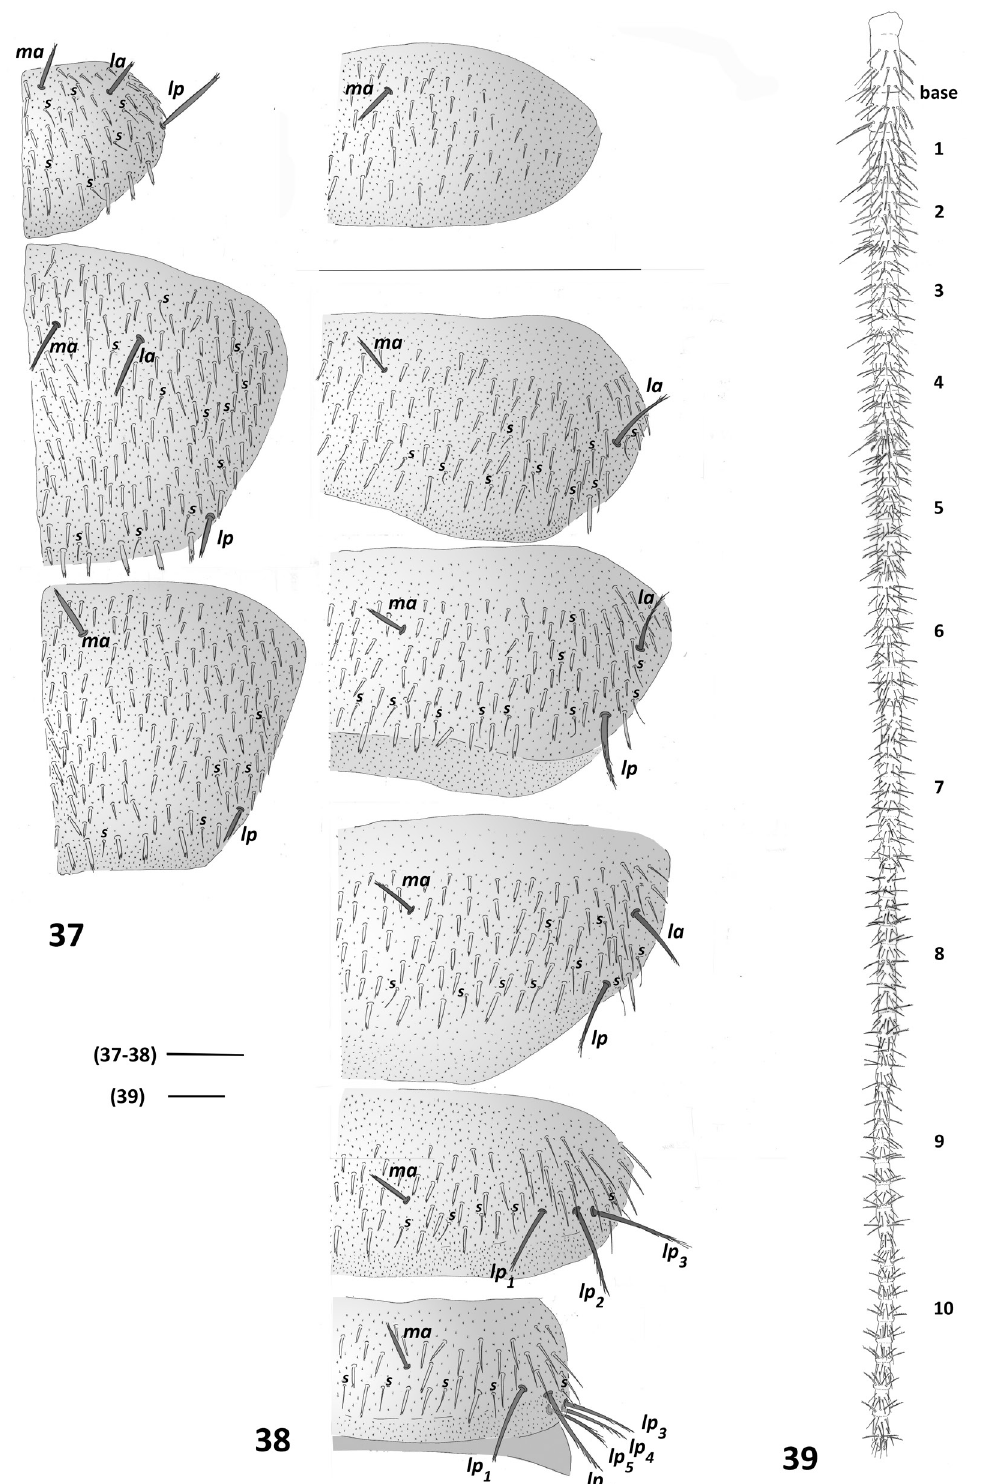
Figs 37–39. Campodea ( Campodea ) lubbockii Silvestri, 1912. 37 . ♀, 4 mm, from Geneva, Switzerland, pronotum, mesonotum and metanotum, right side. 38 . Urotergites I, V–VIII and abdominal segment IX, right side. 39 . ♀, 4.1 mm, from Pichoy, France, right cercus. Abbreviations: see Material and methods. Scale bars: 0.2